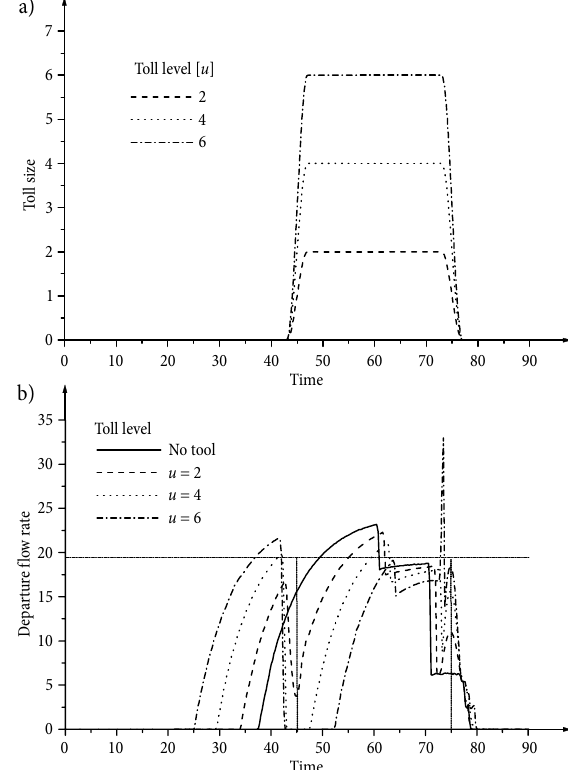
Fig. 6. Solution profiles from the first type of toll